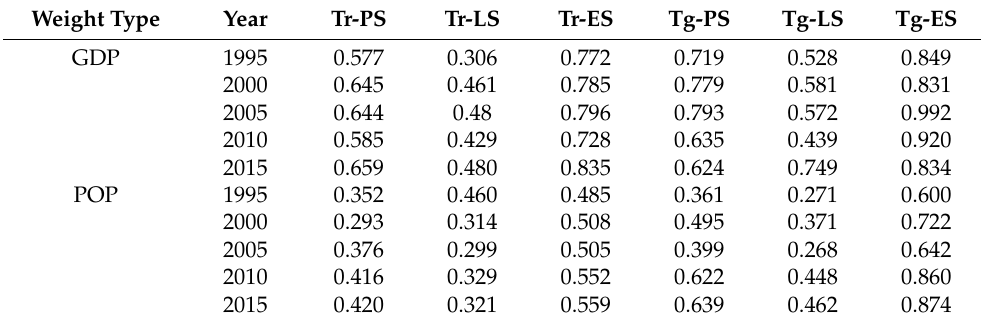
Table 4. Results for the PLES-related Theil index of the two types of cities,